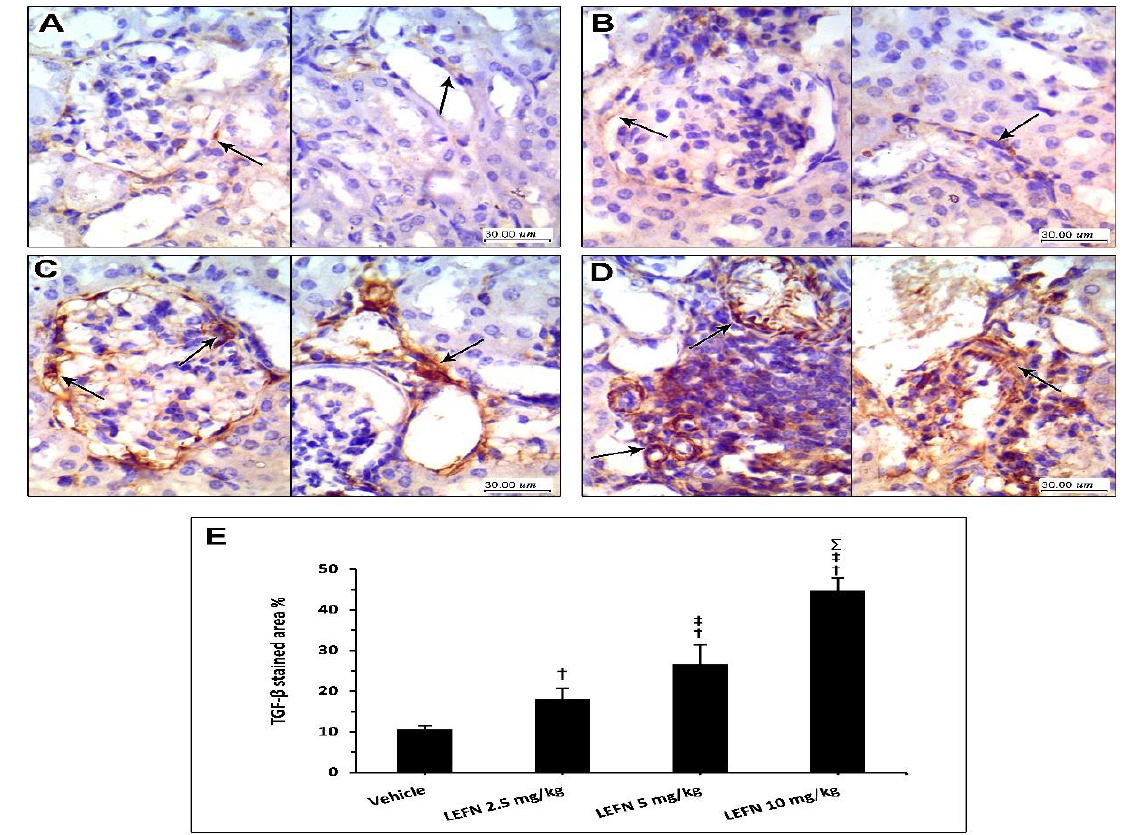
Figure 8. Immunohistochemistry for TGF β in kidney specimens from LEFN-treated mice. ( A ) Sec- tions from the vehicle group show focal weak TGF β -staining in normal kidneys, localized to periglomerular and peritubular areas (in left panel), and focal minimal staining in perivascular areas (right panel). ( B ) Sections from the LEFN 2.5 mg/kg group show faint focal staining of TGF β in periglomerular areas (left panel) and minimal focal weak staining in peritubular areas (arrow in right panel). ( C ) Sections from the LEFN 5 mg/kg group show moderate staining of TGF β encircling periglomerular areas (left panel), and this is also seen in perivascular areas or focally in peritubular areas (right panel). ( D ) Sections from the LEFN 10 mg/kg group show moderate to strong staining of TGF β , especially in areas surrounded by inflammatory cells infiltrate (left panel), and perivascular and peritubular areas (right panel), arrows in all images indicate positive staining. ( E ) Column chart for mean ± SD of the stained area % in kidney specimens from the experimental groups. †: versus the vehicle group, ‡: versus the LEFN 2.5 mg/kg group, and Σ : versus the LEFN 5 mg/kg group at p <